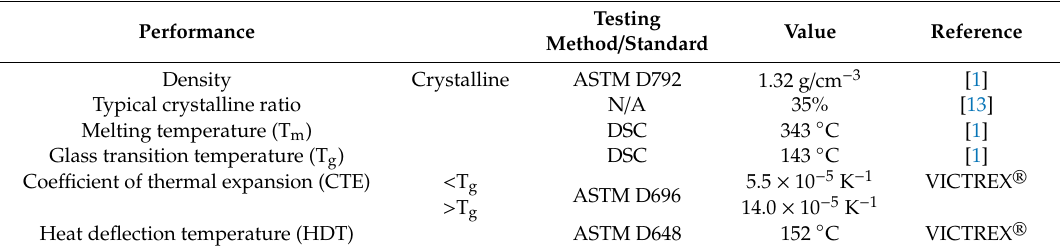
Table 3. Some performance of unfilled PEEK important for 3D